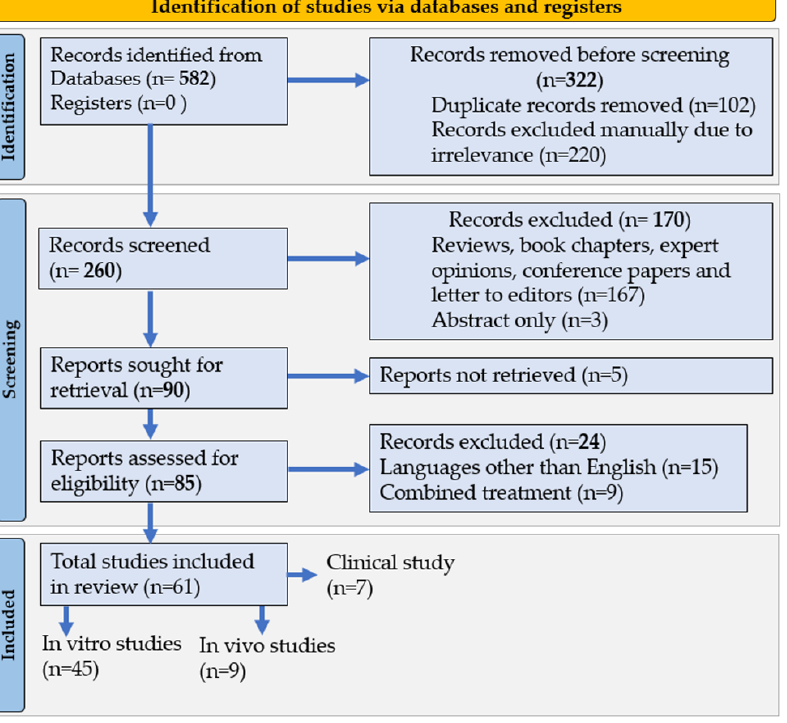
Figure 1. PRISMA 2020 flow diagram for the systematic review of dendritic cell (DC)-based cancer immunotherapy with medicinal plants and their phytochemicals.